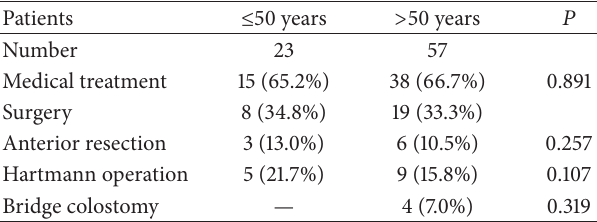
Table 4: Surgical and medical